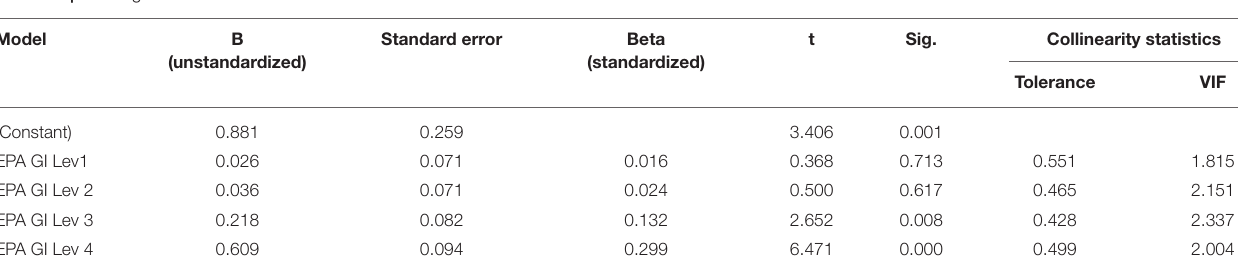
TABLE 5 | OLS regression for GI EPA 5 a .